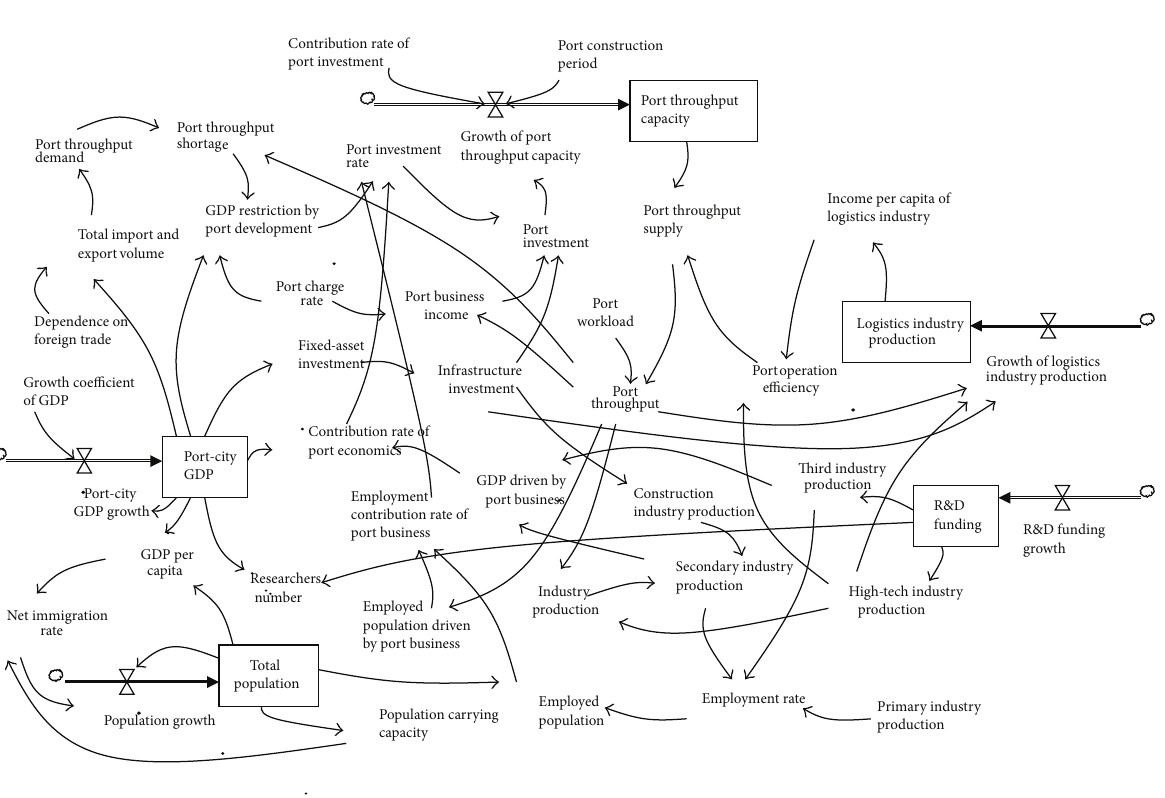
Figure 2: The flow diagram of port-city interaction